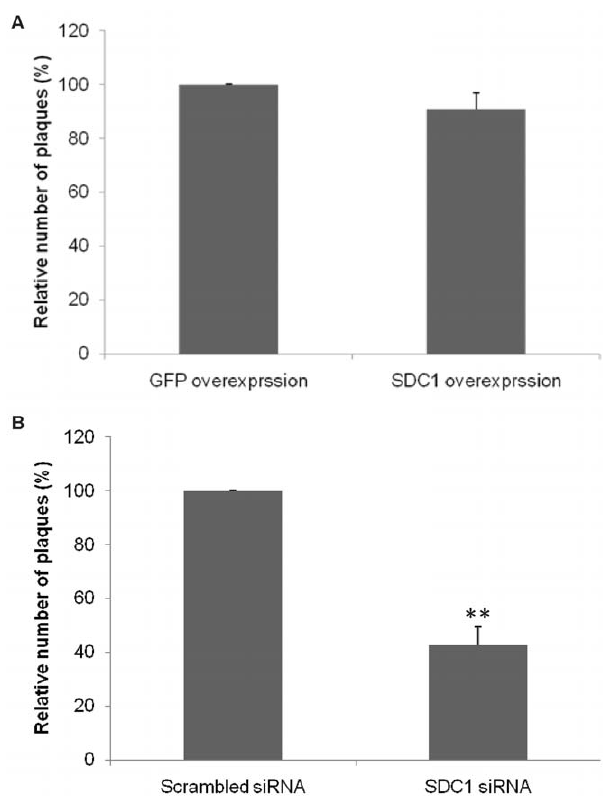
Figure 5. Syndecan-1 knockdown reduces plaque formation in HCE cells. (A). Monolayers of HCE cells were transfected with either control plasmid GFP, or with human syndecan-1. 24 h post-transfection cells were infected with serial dilution of HSV-1(KOS) stocks. (B). 50% confluent HCE cells were transfected with either control scrambled siRNA or syndecan-1 specific siRNA. 72 h post-transfection, cells were infected with serial dilution of HSV-1(KOS) stocks. (A, B). 72 h post- infection cells were fixed and stained with crystal violet stain. Infectivity was measured by the number of plaque forming units (PFUs). Number of PFUs was counted at the 10 6 objective (Zeiss Axiovert 200). Plaques consist of 15 or more nuclei were counted. Results are means 6 1 SD of three independent experiments conducted in duplicate. SDC1 , synde- can-1.